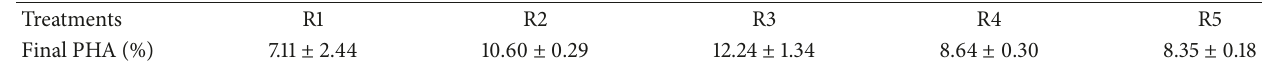
Table 2: The final PHA for the five composting